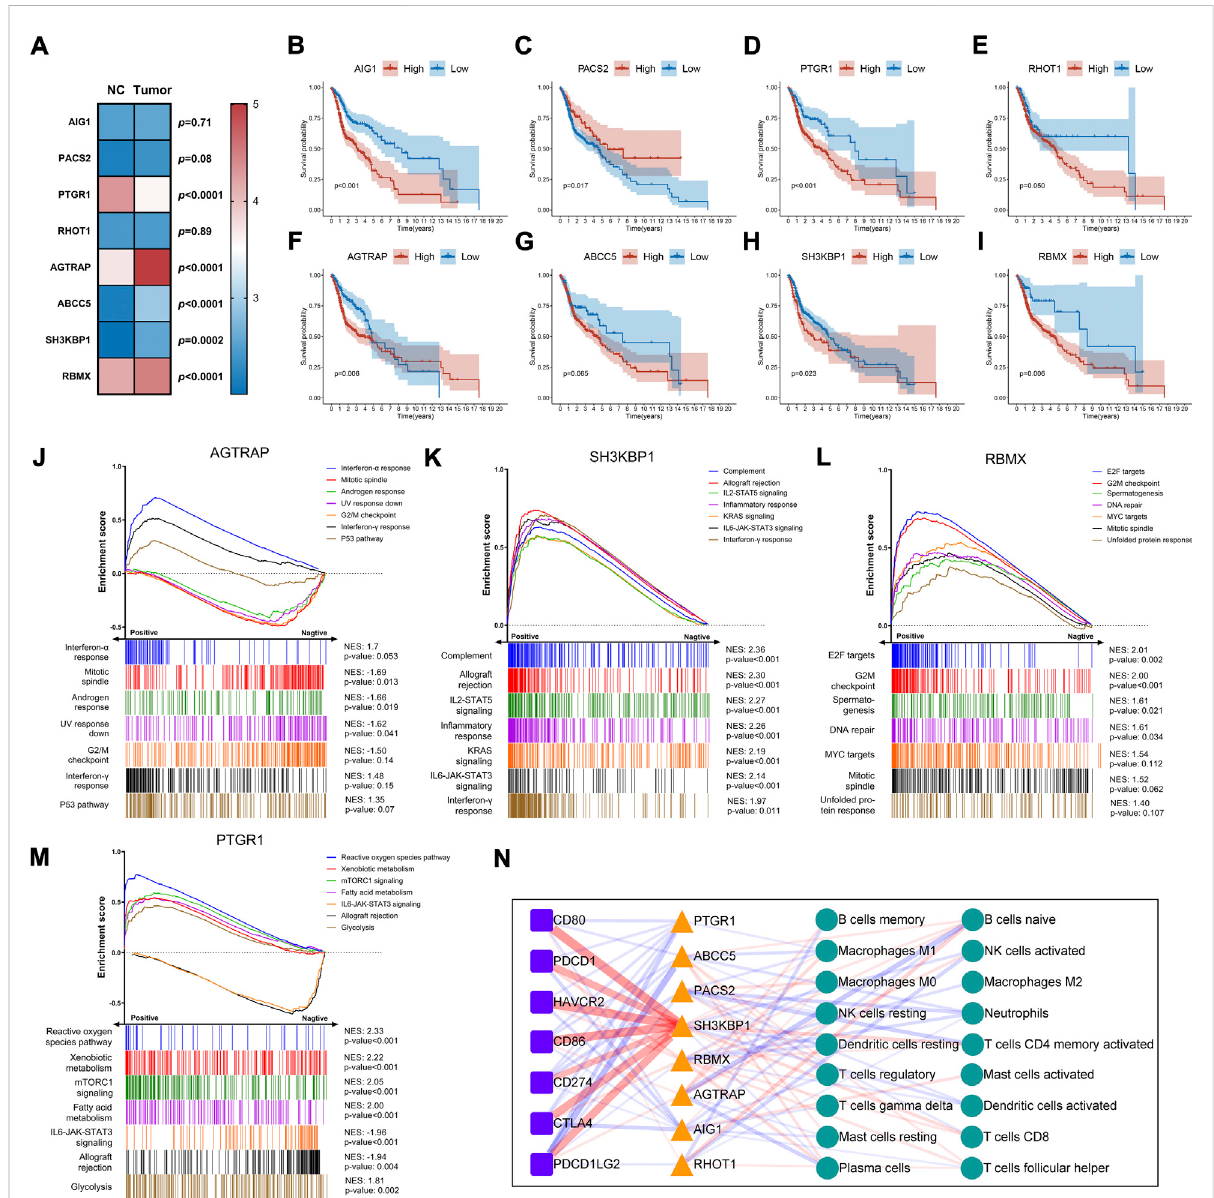
FIGURE 6 ExpressionandfunctionalanalysisoftheparentgenesofASinvolvedinprognosticsignature. (A) Heatmapanddifferentialexpressionanalysisof the parent genes between HNSC and normal samples. The fi lled color represents the log2 (FPKM value) for each gene. Data were analyzed using Mann-Whitney nonparametric test. (B – I) Kaplan-Meier survival curve of overall survival for each parent gene. Log-rank test was used for data analysis. (J – M) GSEAplotsforthetopsevenHallmarkgenesetssigni fi cantlycorrelatedwiththeparentgeneexpression.Theenrichmentscores were calculated with gene expression lists ranked by pearson. NES, normalized enrichment score. (N) The network diagram shows the correlation between parent genes, immune checkpoints, and immune cell subsets (CIBERSORT). Colored triangles, squares, and circles represent respectively parent genes, immune checkpoints, and immune cells, respectively. The thickness of the line represents the strength of correlation. Red and blue represent positive and negative correlation, respectively. Data were analyzed using Spearman ’ s correlation